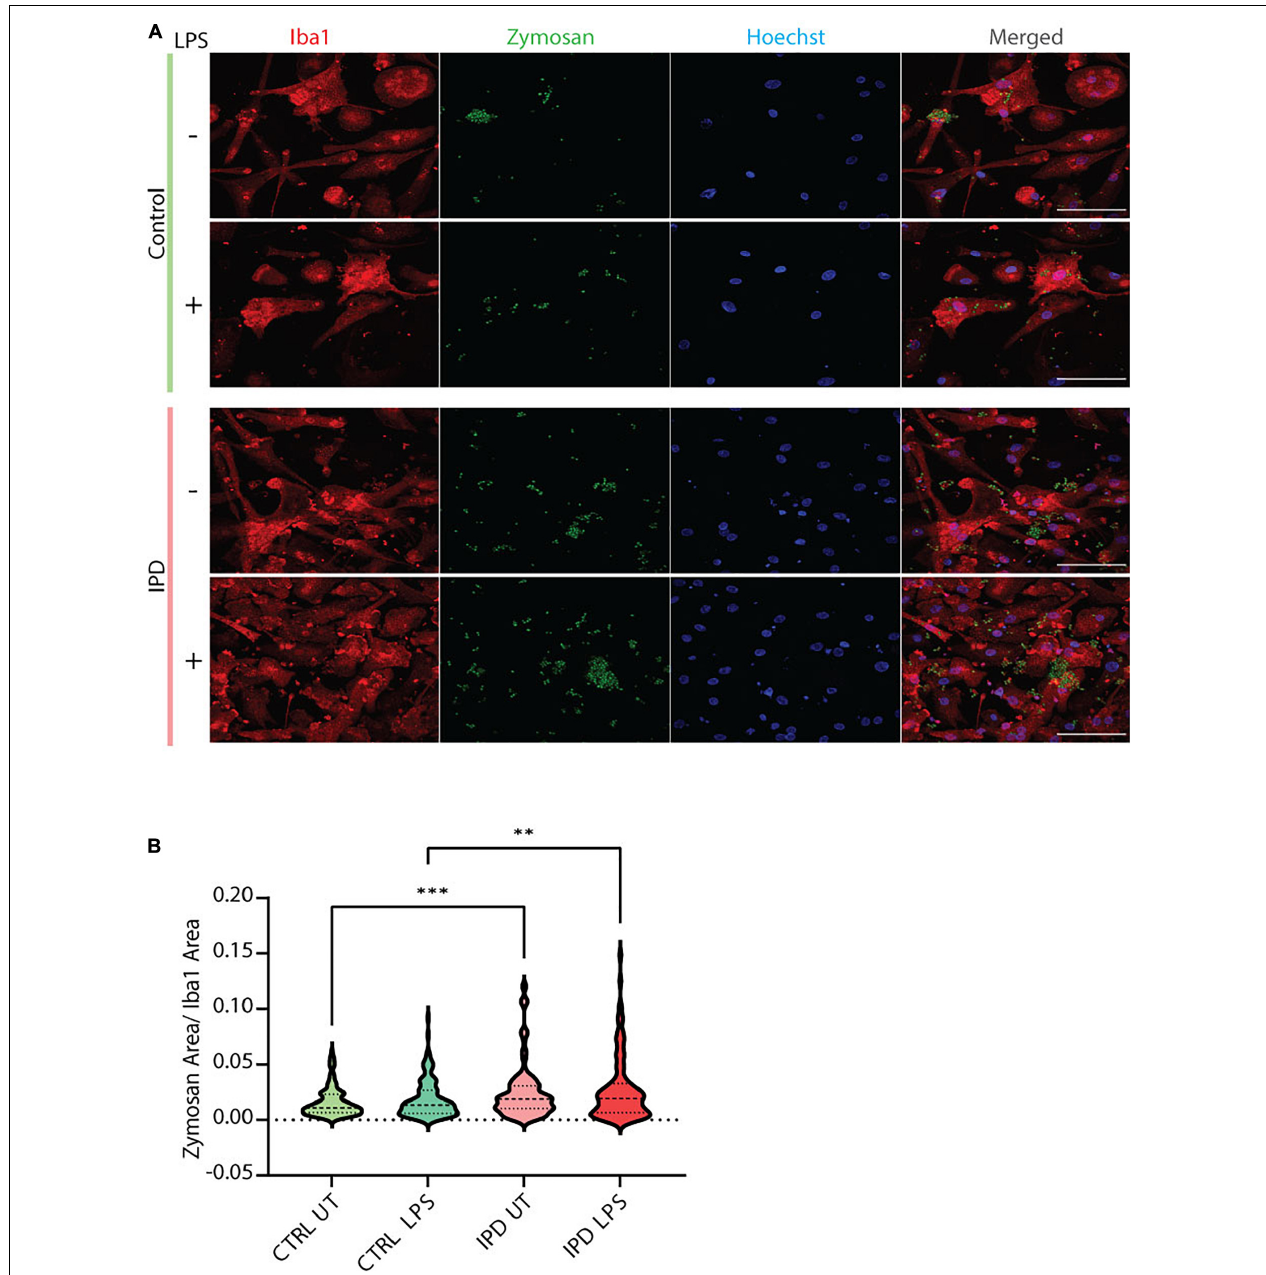
FIGURE 3 | Functional assessment of iPSC-derived microglia. (A) Representative immunostaining showing the functional ability of cultured control and IPD microglia treated with Zymosan bioparticles. Scale bar, 50 µ m. (B) Quantification of data from (A) ; IPD microglia have higher phagocytic capacity (Zymosan area was normalized for Iba1 area) compared to control cells. ∗∗ p < 0.01; ∗∗∗ p < 0.001; IPD, idiopathic PD; CTRL, healthy